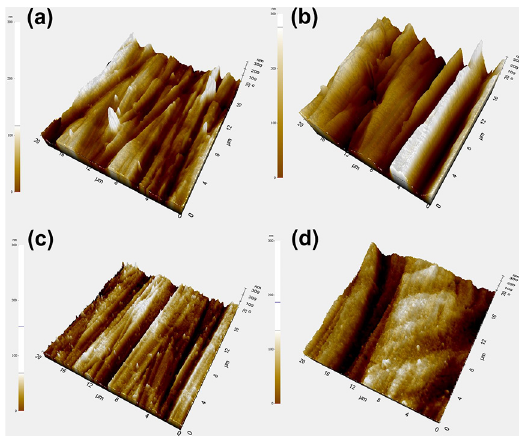
Figure 2. AFM images for the synthesized films on stainless steel: a) pristine TiO